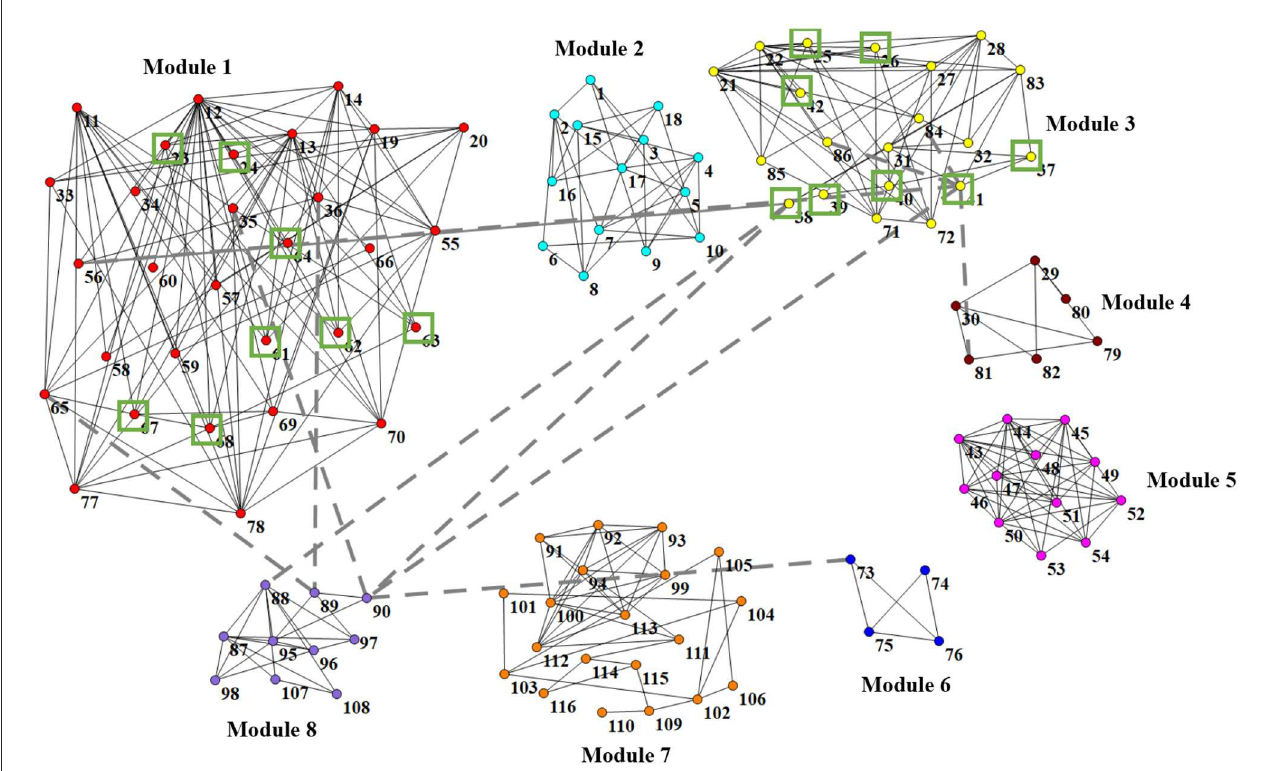
FIGURE6 Identified 8 modules of the average network (among training subjects), where nodes with the same color belong to the same module. Gray dotted lines represent the 12 most discriminative connections. Green boxes denote 16 brain regions that are related to MCI (Suk et al., 2015; Yu et al.,